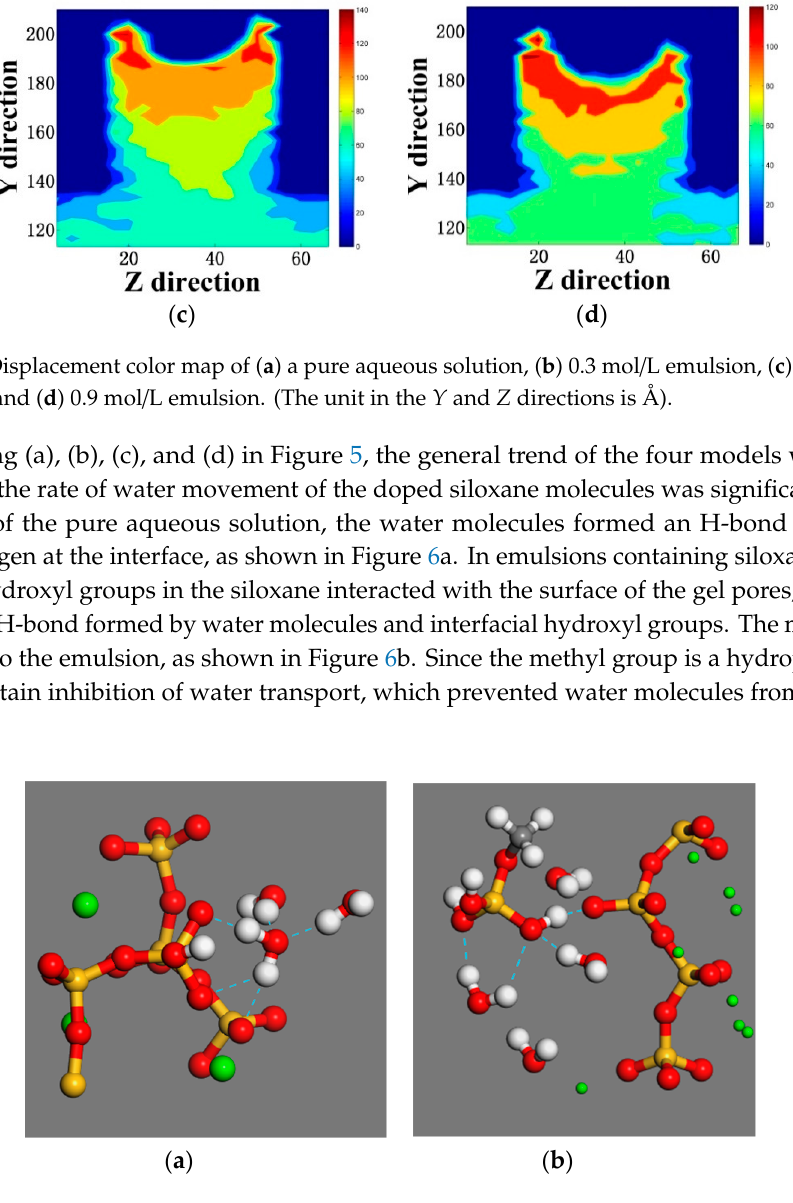
Figure 6. ( a ) Water molecules and interface hydrogen bond. ( b ) Schematic diagram of hydrogen bonding between siloxane molecules and interfaces.